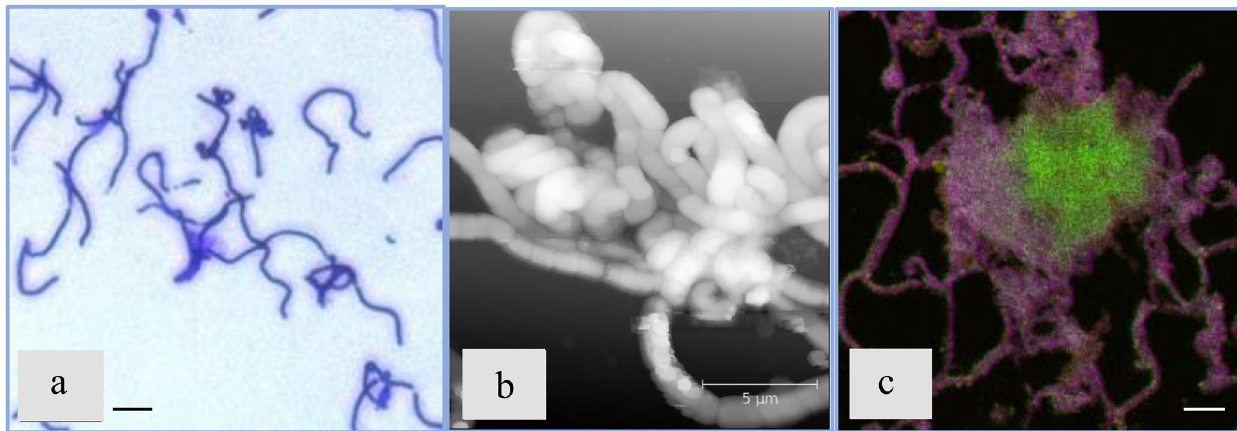
Fig. 2 B. cereus 4B at the fi rst stage of the growth (0 – 15 hours after inoculation). a Light-microscopy image with crystal violet staining in the sample taken after 9 hours after the inoculation. b AFM microscopy image (after 15 h). c Confocal microscopy image with Sytox green staining (green color, speci fi c for eDNA), Congo Red (pink color, amyloids and polysaccharides) and CaCO 3 auto fl uorescence channel (yellow color); All scale bars correspond to 5 µm.